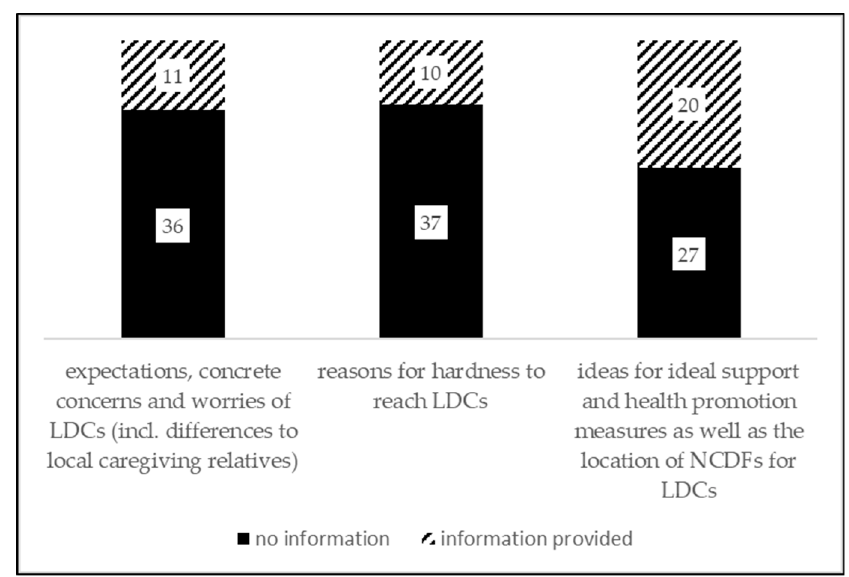
Figure 1. Available information on LDCs.